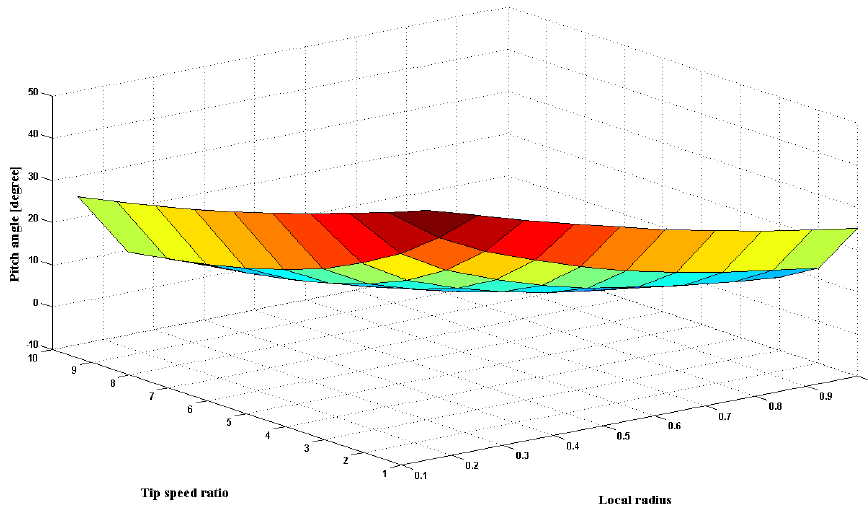
Figure 10. Relationship between the tip speed ratio, the local radius, and the pitch angle at the radius of blade of 0.65 m.